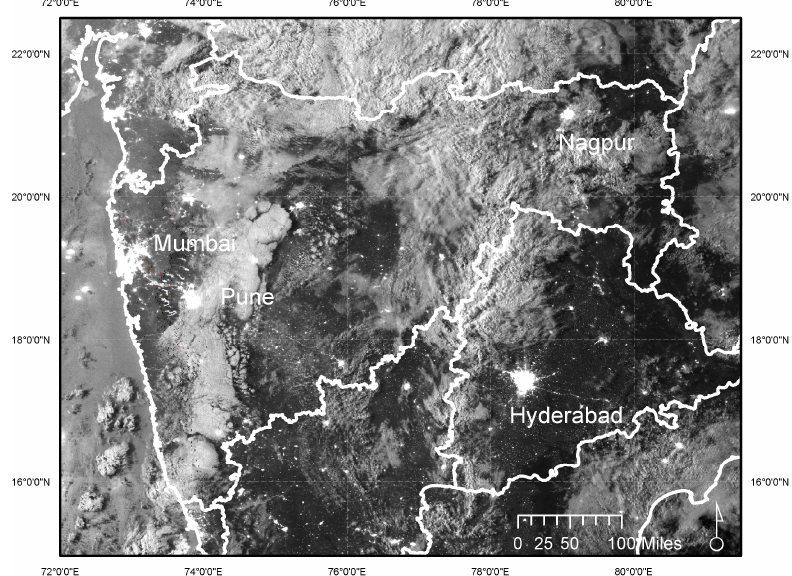
Figure 1. Example of raw day/night band (DNB) radiance values for Maharashtra and adjacent states. Levels of reflected and emitted light detected by the DNB ( greyscale ), with state boundaries highlighted ( white lines ), image taken 1 January 2015.